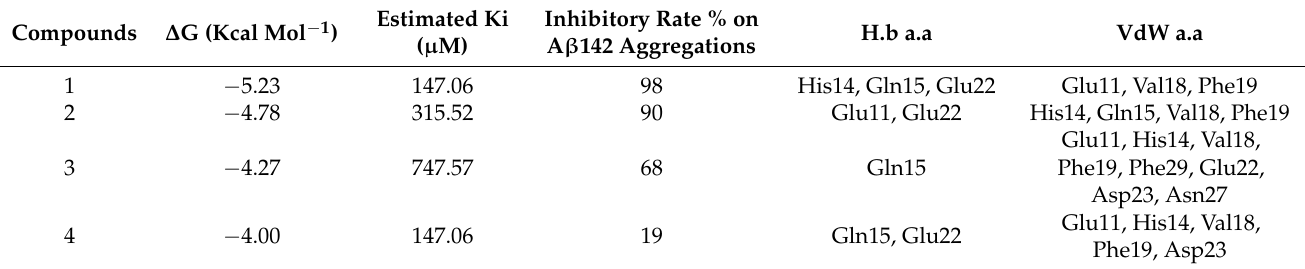
Table 1. Amino acid residues of A β 42 that interact with compounds 1 – 4 and their ∆ G values obtained via docking